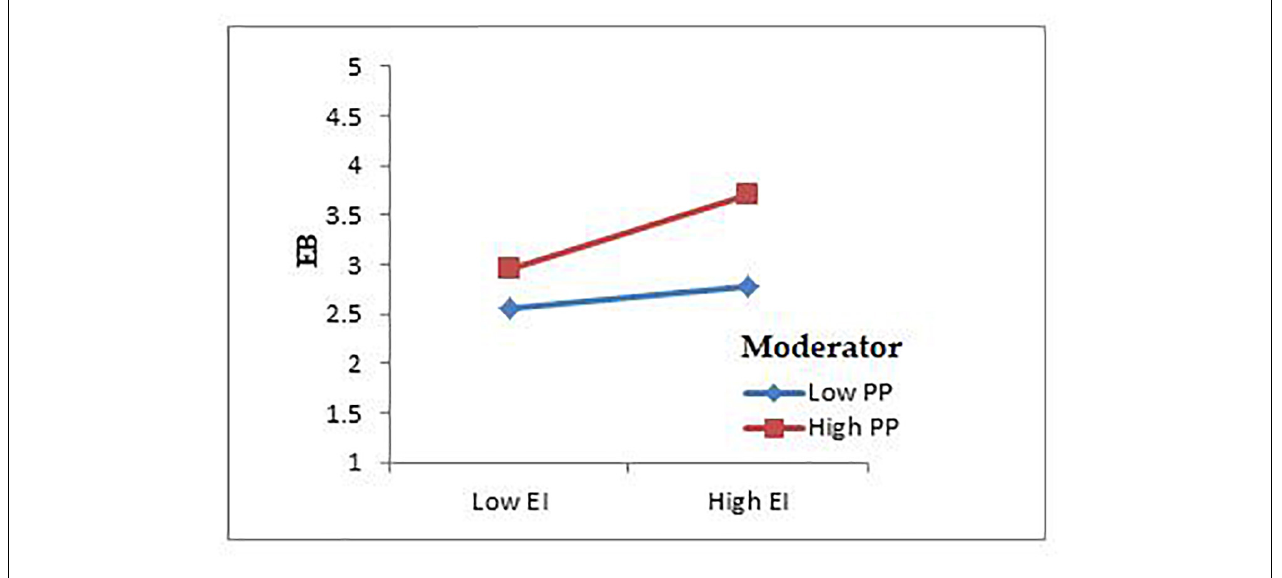
FIGURE 3 | Interaction PP*EI and